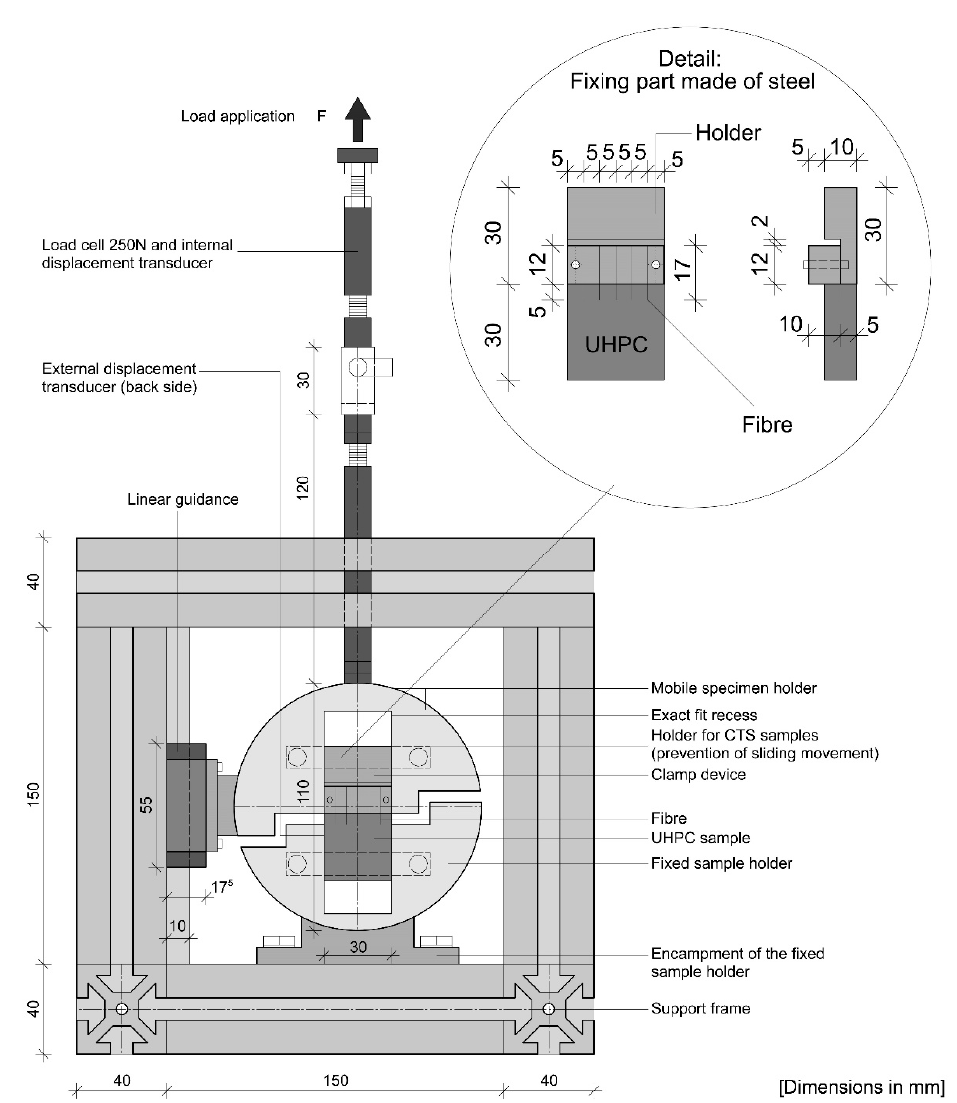
Figure 5. Front-view of the setup for the fibre pullout tests. CTS testing device and fibre fixing holder. All dimensions labelled in mm.